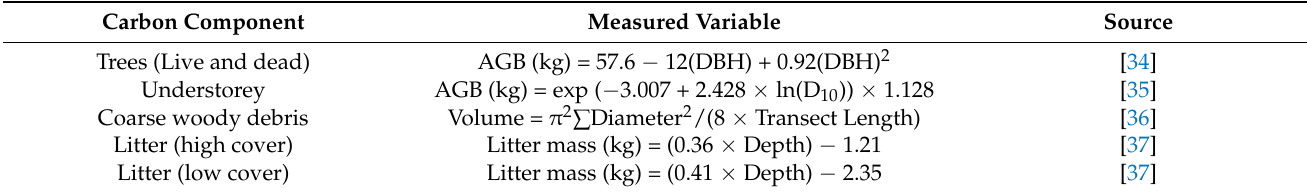
Table 1. Equations used to estimate biomass in each carbon pool and the sources they were derived